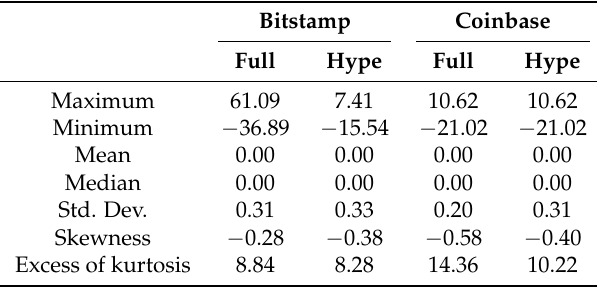
Table 4. Summary statistics of the 5 min Bitcoin log returns. Results are reported for the two exchanges Bitstamp and Coinbase over the full period “Full” and conditional on the Hype